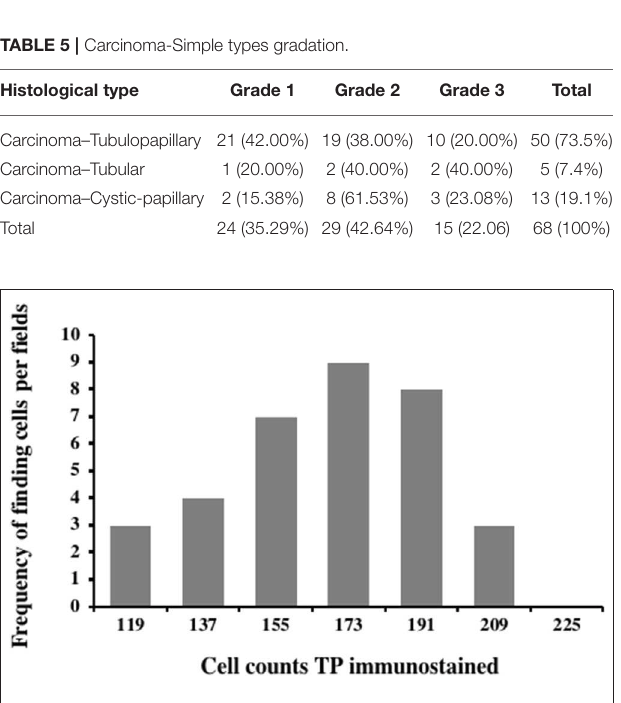
FIGURE 1 | Frequency-distribution of the cell TP immunostained per field from 44 samples corresponding to G2 and G3. A normal distribution was observed in the range between 103 and 205 of TP immunostained cells with a mean of 153.35 ± 4.8, median: 155.5, variance: 790.53, and class value of